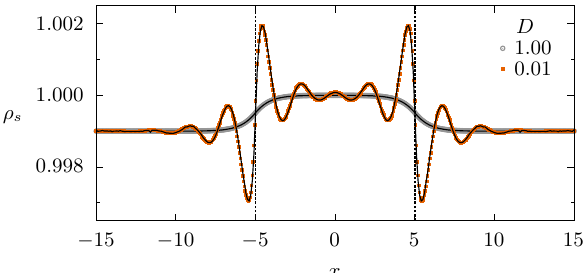
Figure 3. Stationary population density ρ s vs. x in a refuge. This heterogeneous environment is defined by 3 and L 1 , A 10 10 . The vertical lines indicate the refuge boundaries. We used b Eq. (6), with a − = = = = 2 , and two different values of D . Symbols are results from numerical 0.1 and ℓ the kernel γ q ( x ) , with q = = integration of Eq. (3) under periodic boundary conditions, and solid lines from the small- A approximation given by Eq. (8), in excellent agreement with the exact numerical solution. Recall that, in a homogeneous 0 environment, no oscillations appear for q ≥